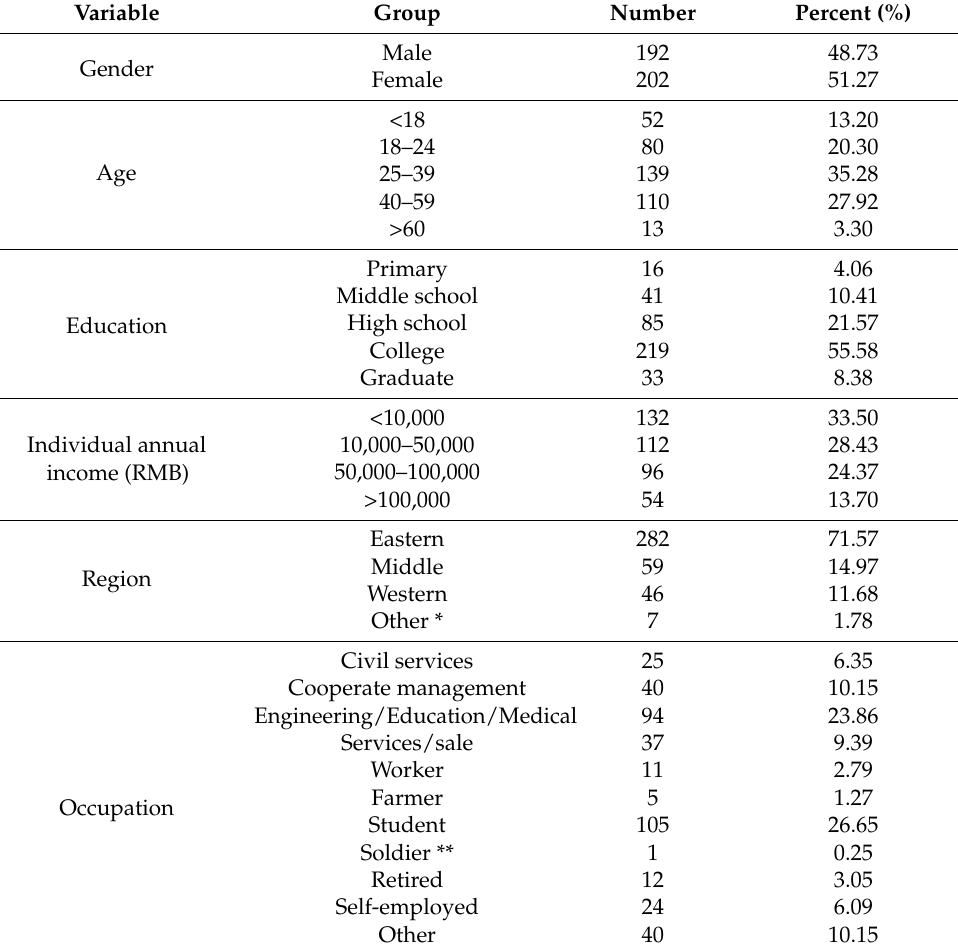
Table 1. Demographic characteristics of the